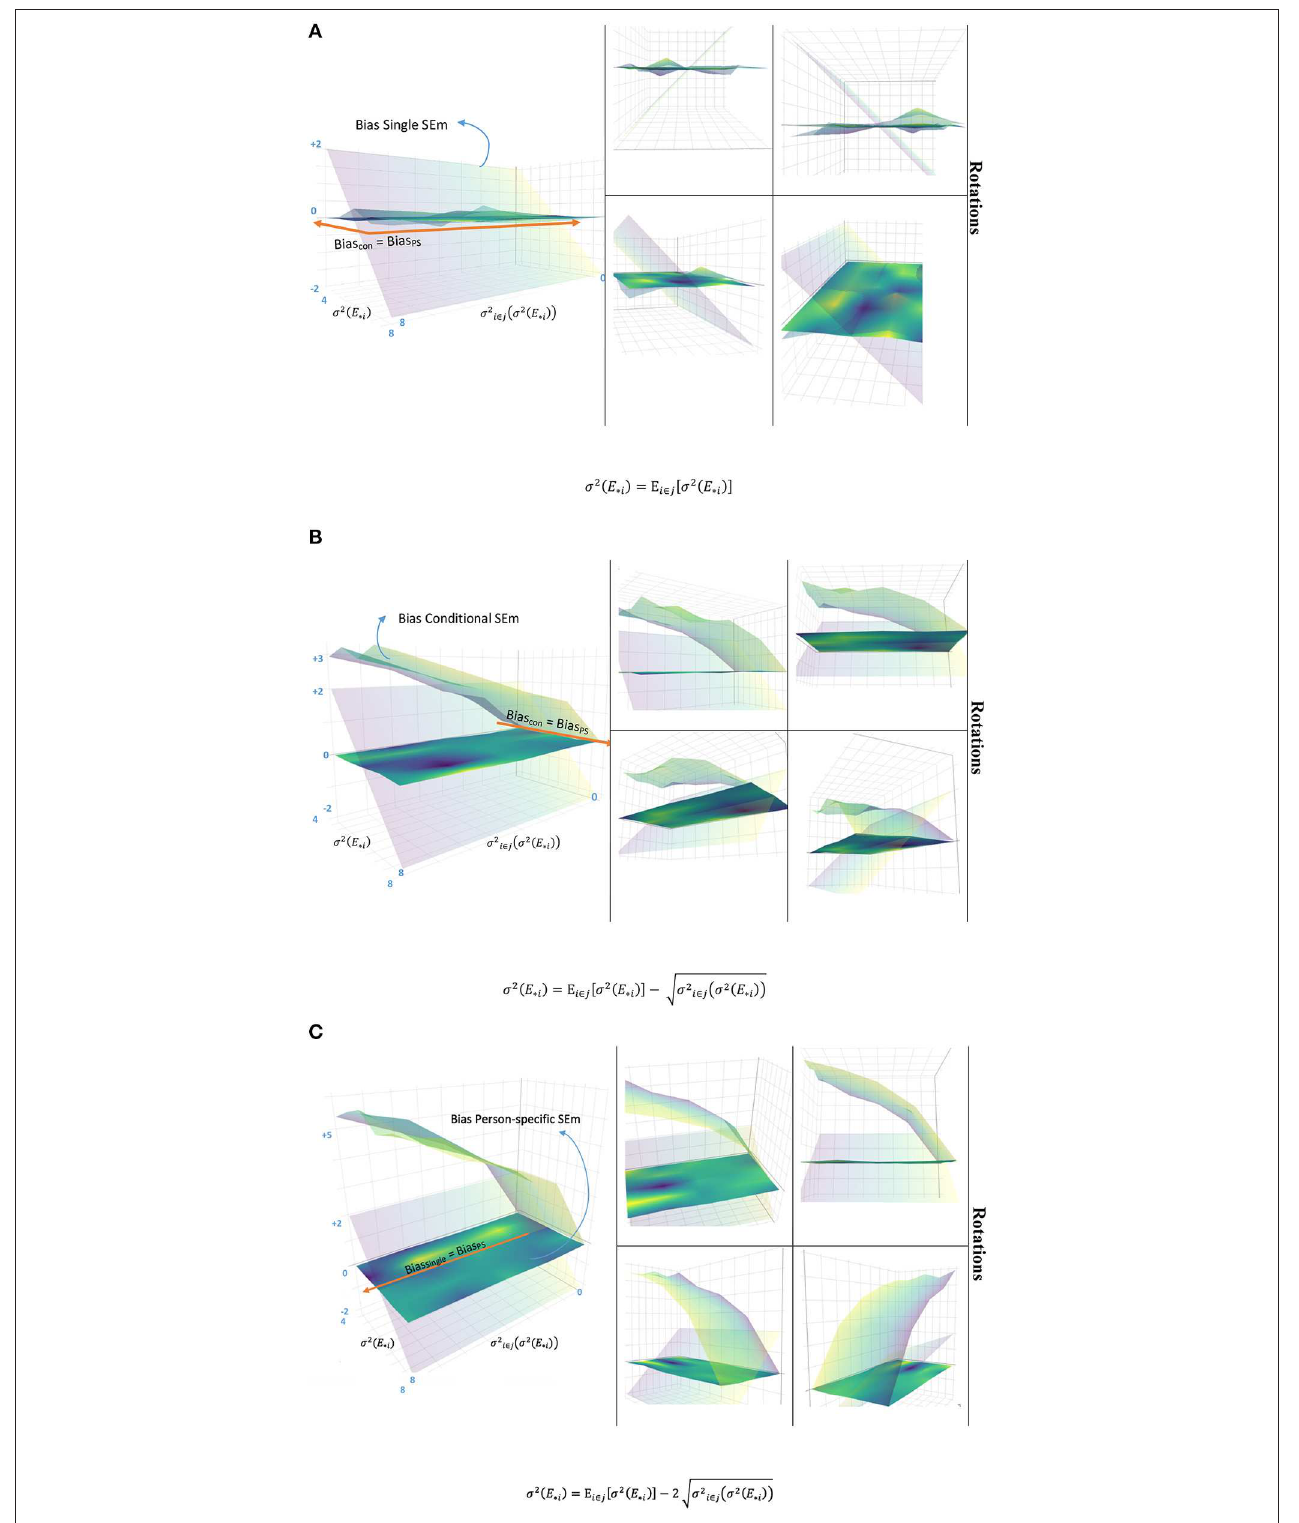
FIGURE 3 | Relationship between the bias of the person-specific -, conditional-, and single SEm variance, for a fictional examinee i . When the error variance of examinee i equals the average error variance in group j (A) , both the person-specific SEm and the conditional SEm provide an unbiased estimate. When this is not the case (B,C) , the bias of the conditional SEm increases rapidly, with increasing variance over the error variances within group j (y-axis). The single SEm (tilted vertical surface) is only unbiased when the error variance of the examinee (x-axis) coincides with the average population error variance (visible in A–C ). To aid interpretation, different rotations of the A–C figure are included at the right